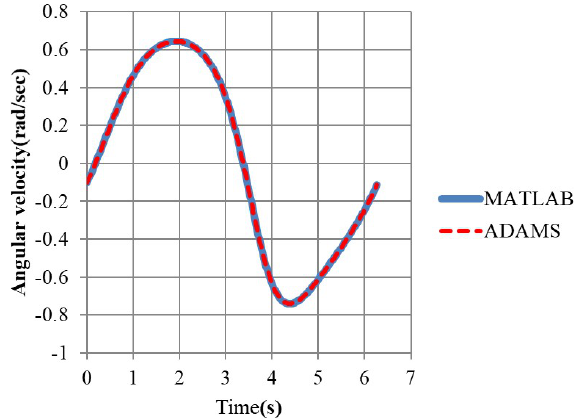
Figure 9. Comparison of our modeling computation with that of ADAMS on ω 6 .